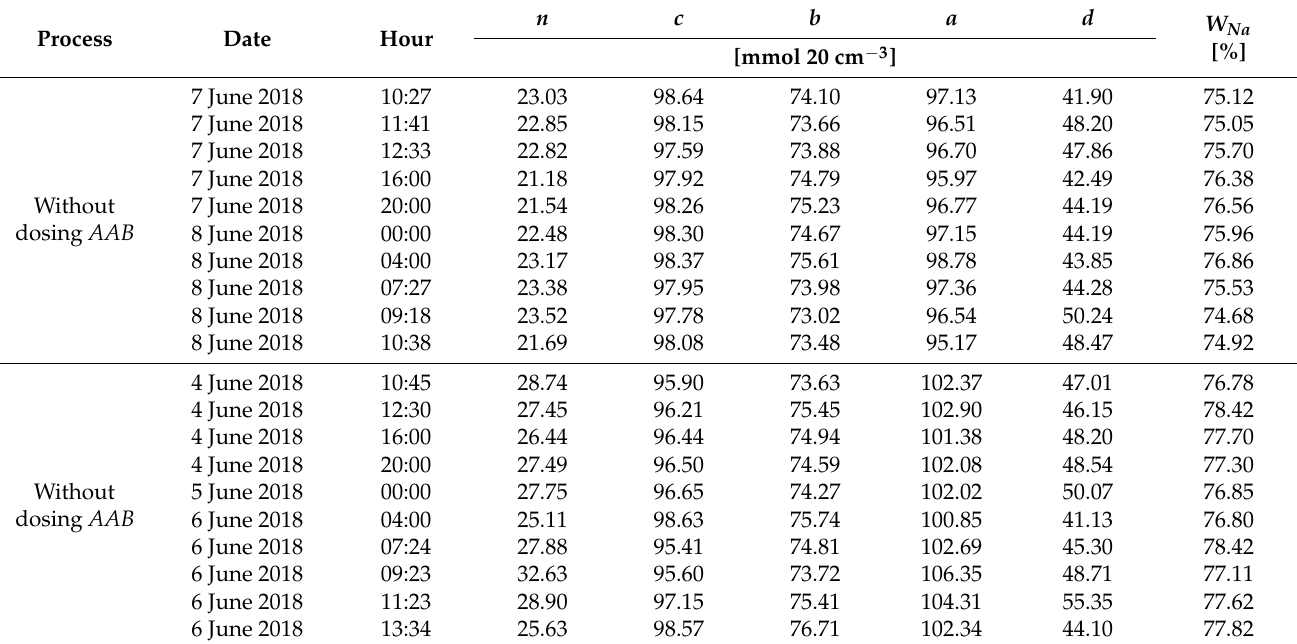
Table 3. Selected results with and without dosing AAB to carbonization column.